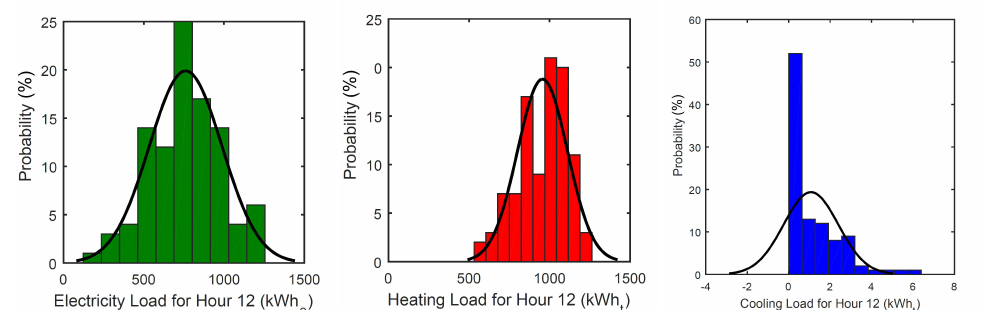
Figure 20. Probability of electricity load ( left ), heating ( center ), and cooling load ( right ) of the 12th hour on 21